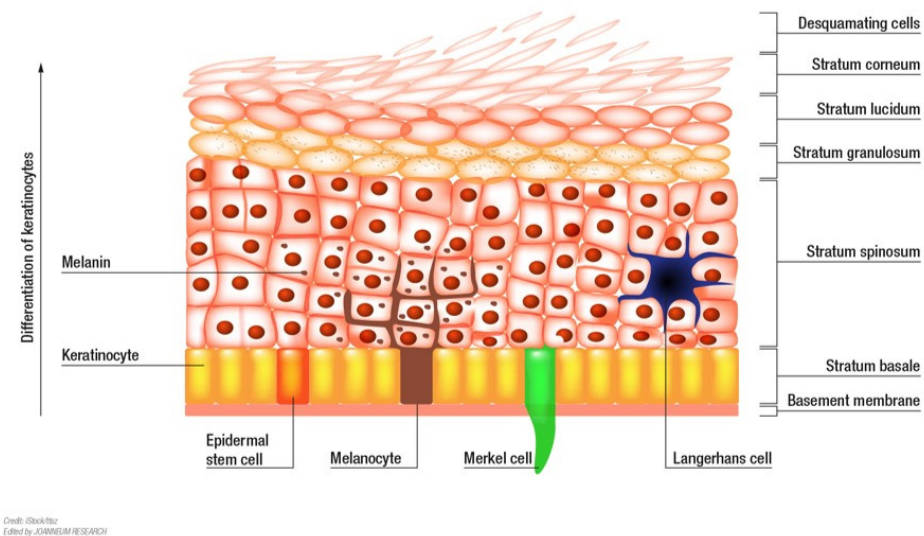
Figure 2. Epidermal structure in detail. The epidermis is a stratified squamous epithelium composed of multiple layers of keratinocytes. Basal keratinocytes proliferate and give rise to suprabasal successor cells that undergo a tightly controlled differentiation program to form distinct epidermal layers. In the stratum spinosum keratinocytes are already post-mitotic. Granular keratinocytes are terminally differentiated keratinocytes expressing loricrin, filaggrin and transglutaminase. Kerato- hyalin granules contain filaggrin and regulate hydration and cross-linking of keratin filaments. Upon differentiating to corneocytes, granular keratinocytes produce and secrete lamellar bodies, containing lipids and proteins, to the extracellular space, resulting in formation of hydrophobic cornified envelope. Corneocytes are non-living cells that form the outermost layer, which is respon- sible for the water impermeability of the skin. Apart from keratinocytes, which represent the major cell type in the epidermis, other cell types including melanocytes, Merkel cells and Langerhans cells are also present [15,16].